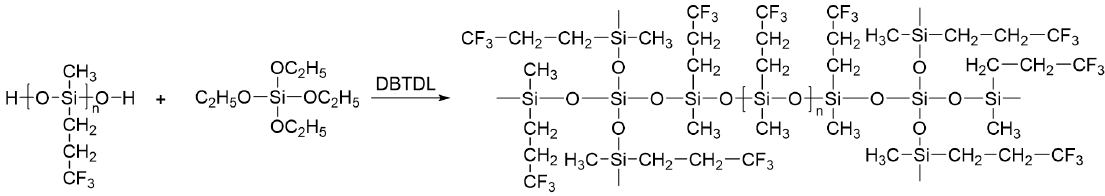
Figure 2. Crosslinking reaction mechanism of the fluorosilicone coatings. Table 1. Formulation of studied coatings (g).